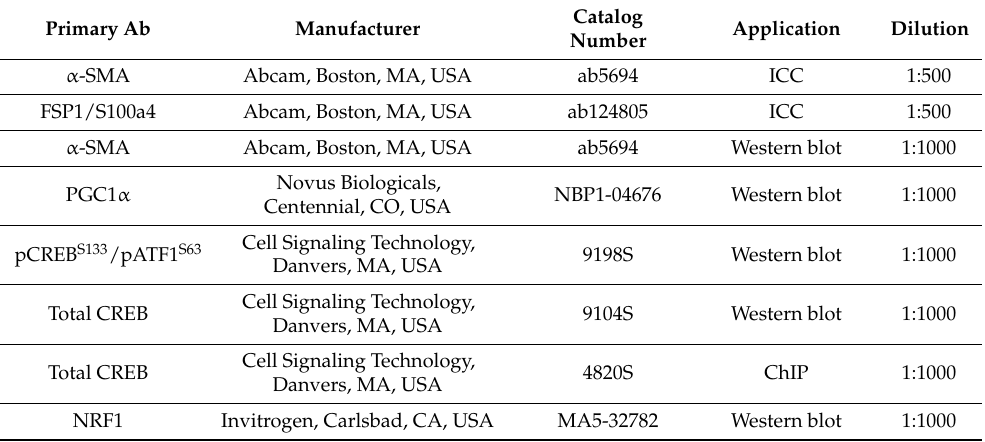
Table 1. List of Primary antibodies used for Western blot and Immunocytochemistry.